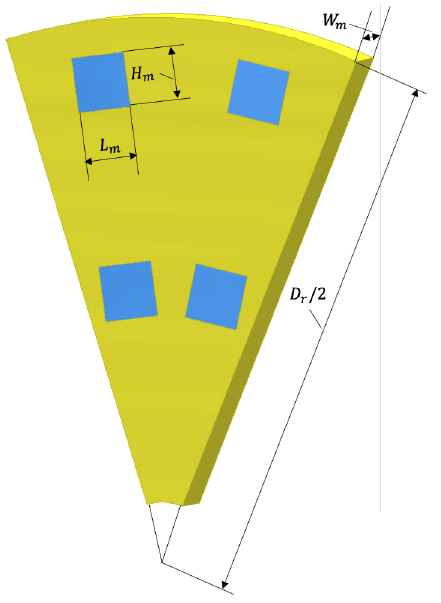
Figure 5. Rotor-housing dimensions. Table 2. Main dimensions.